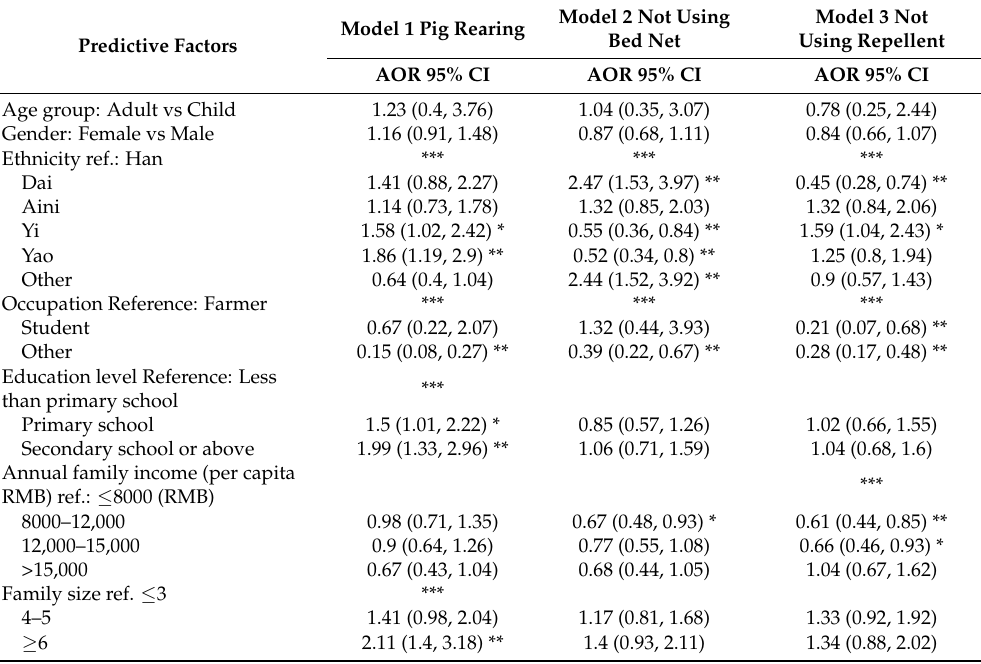
Table 4. Associations between sociodemographic factors and bad MBD behaviors. Model 1 Pig Predictive Factors